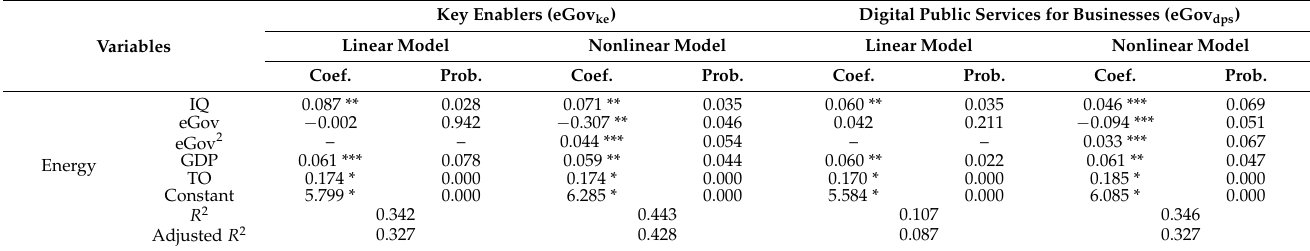
Table 6. The findings of the long-run relationship between the analyzed variables: FMOLS.